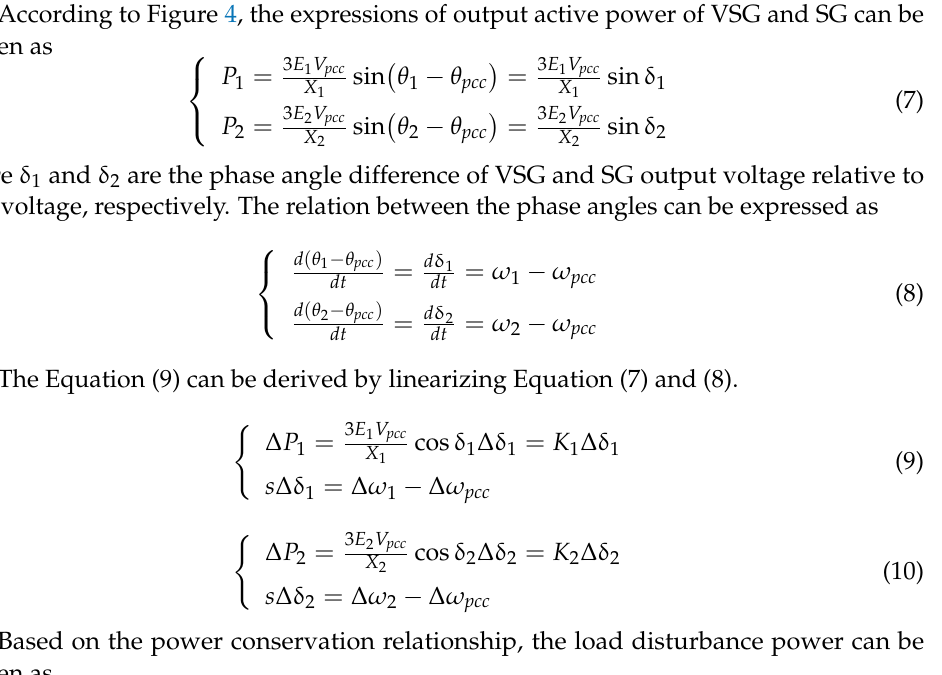
Figure 4. Equivalent circuit of VSG-SG coupling system.